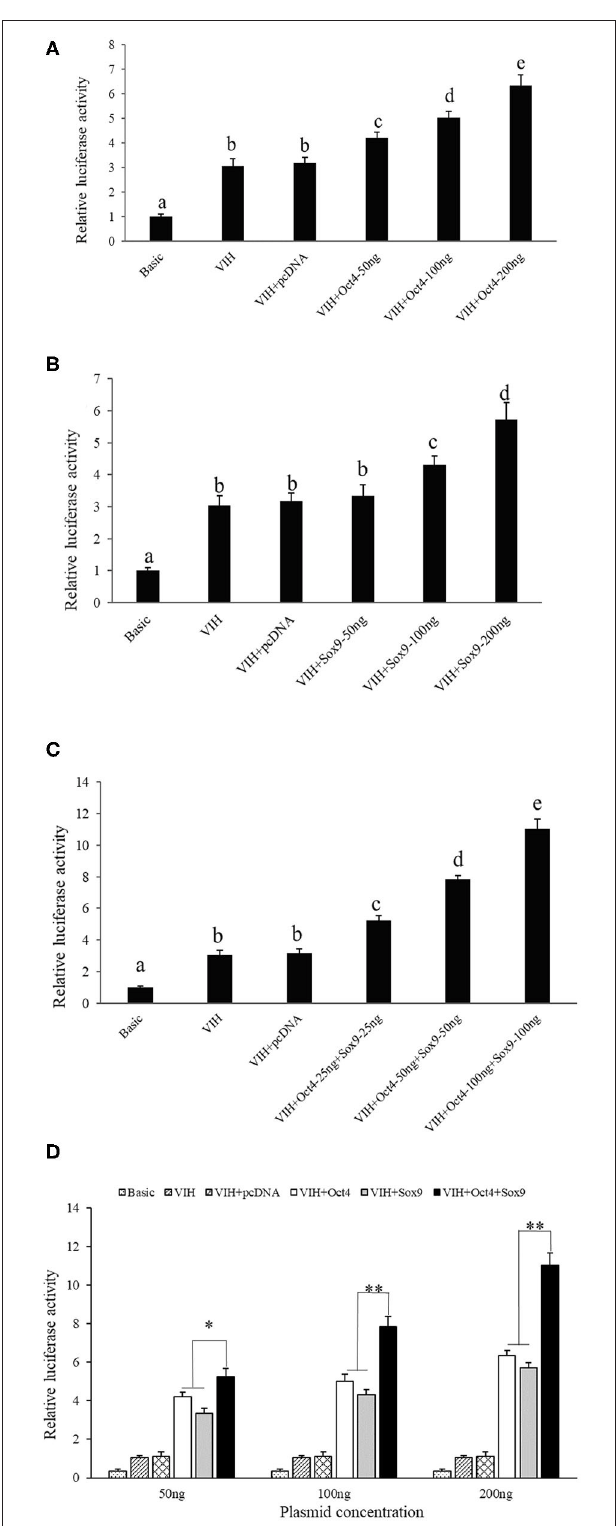
FIGURE 2 | Overexpression of transcription factors can promote the activity of SpVih core promoter in HEK293T cell. (A) Effect of Oct4 gene overexpression on SpVih core promoter activity. (B) Effect of Sox9 gene overexpression on